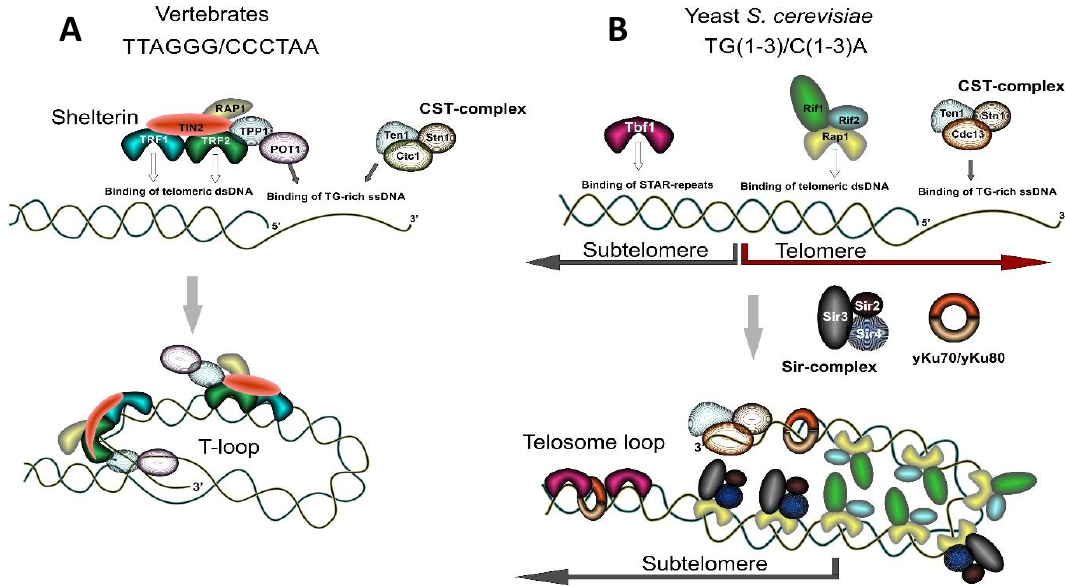
Figure 1. Abridged scheme of telomere organization in vertebrates and in budding yeast showing major telomere-specific protein. ( A ) Schematic representation of the shelterin complex and CST-complex bound to a vertebrate telomere. TRF1 and TRF2 proteins bind to the double-stranded telomeric DNA, POT1/TPP1 and CST-complex bind to the G-rich single-stranded telomeric overhang. Invasion of the G-rich overhang into the double-stranded telomeric repeat transforms this protein-DNA complex into a lariat-like structure called a T-loop. Nucleosomes and secondary protein factors implicated in telomere maintenance are not shown. ( B ) Proteins specific to yeast telomeric repeats include Rap1 which binds to the double-stranded telomeric repeat and recruits Rif1 and Rif2 or Sir-proteins, and CST-complex bound to the G-rich single-stranded overhang. The Tbf1 protein binds to human telomeric repeats, called STAR-repeats, located at subtelomeric DNA regions. Yeast telomeres can also form a folded-back structure, called telosome, which is stabilized by protein-protein interactions. Sirtuins and Yku70/Yku80 heterodimer participate in telosome formation and telomere maintenance in yeast.